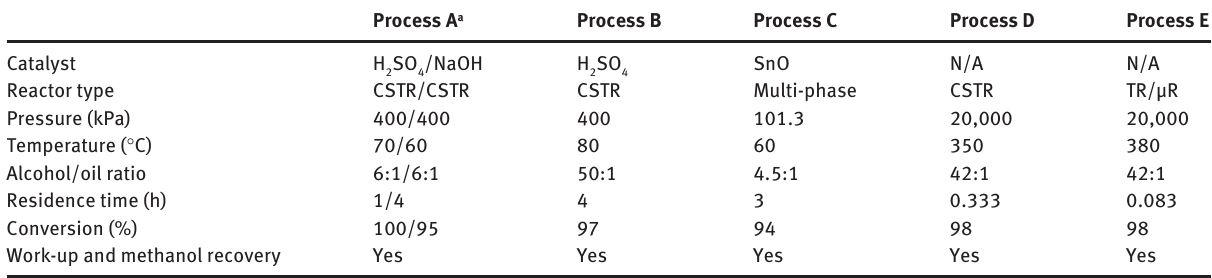
Table 4 Summary of operation conditions modeled in ASPEN Tech for five biodiesel process alternatives utilizing waste oil and methanol in all cases; processes A–D in accordance to West et al. [42]; scenario E taken from Kralisch and colleagues